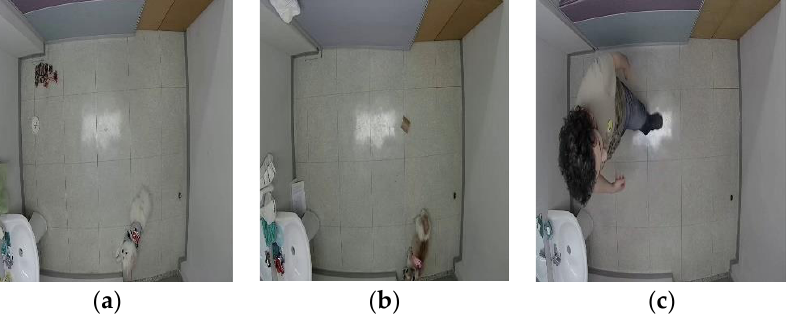
Figure 5. Examples of image data collected: ( a ) example of data collected with a spitz; ( b ) example of data collected with a shih tzu; ( c ) example of data collected with a human.